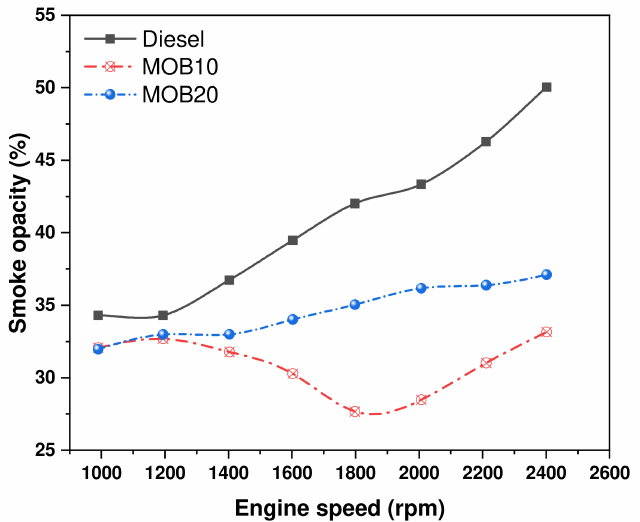
Figure 9. Smoke opacity of Moringa oleifera biodiesel blends and diesel at various engine